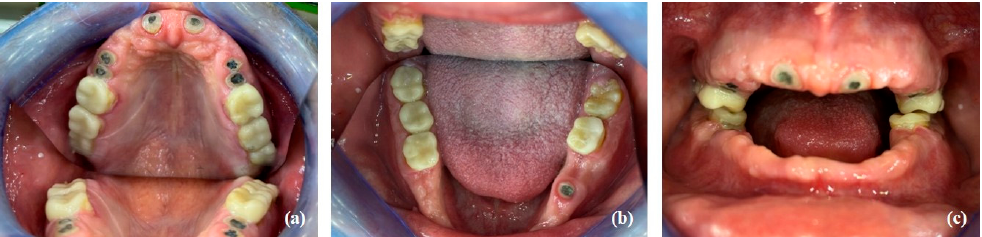
Figure 8 . Onlays in maxillary posterior segment 1: ( a ) Occlusal preparations; ( b ) digital cast; ( c ) design of onlays.